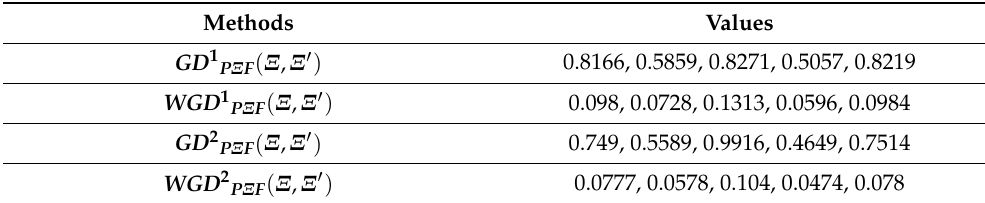
Table 4. Expressions of the measured values using different